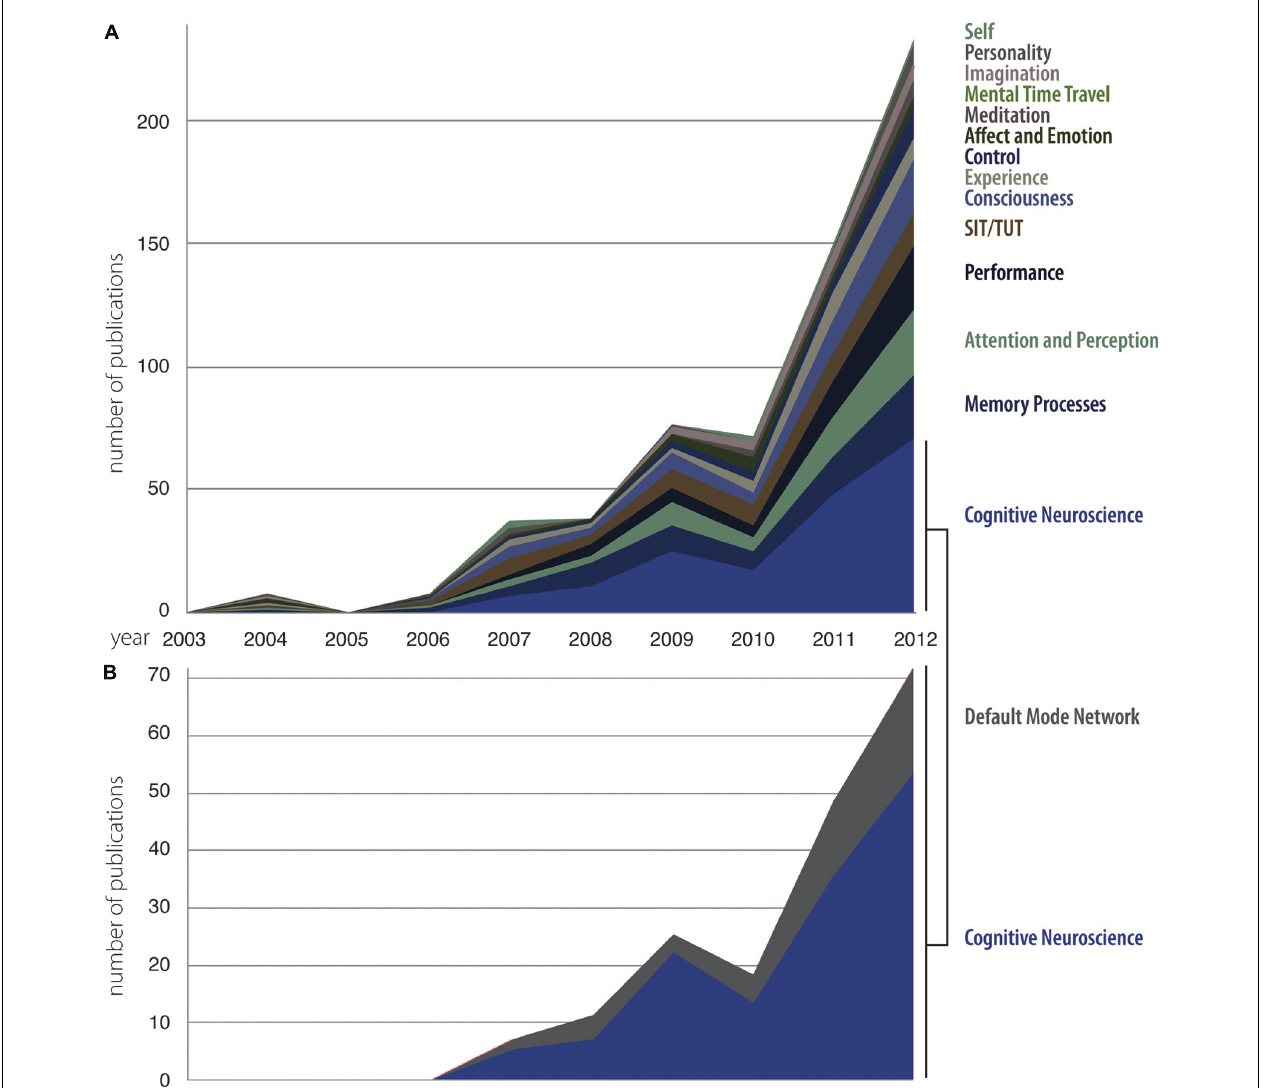
FIGURE 3 | Changes in the categories that form the focus of mind wandering research papers between 2003 and 2012. It can be seen that almost half of the citations refer to psychological phenomena (A) whereas approximately the same amount refer to research focusing on cognitive neuroscience and in particular the default mode network (B)